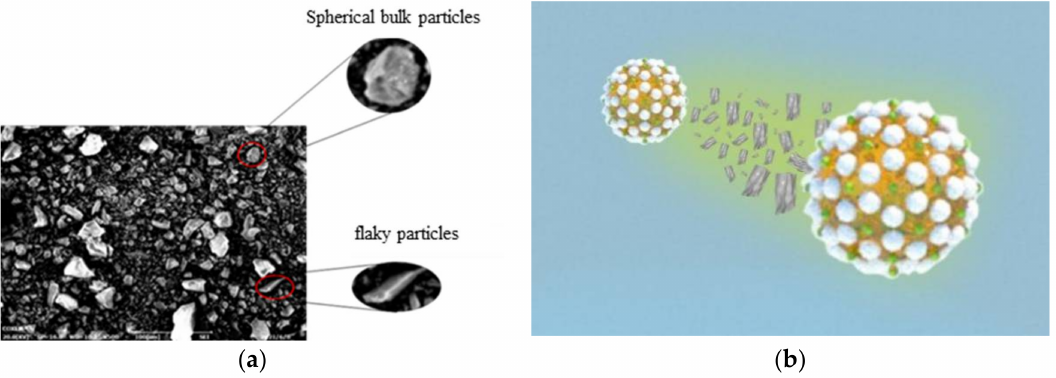
Figure 4. Microscopic morphology of SiO 2 particles and mechanism of emulsion stabilization. ( a ) is the microscopic morphology of SiO 2 particles; ( b ) is the mechanism of emulsion stabilization of SiO 2